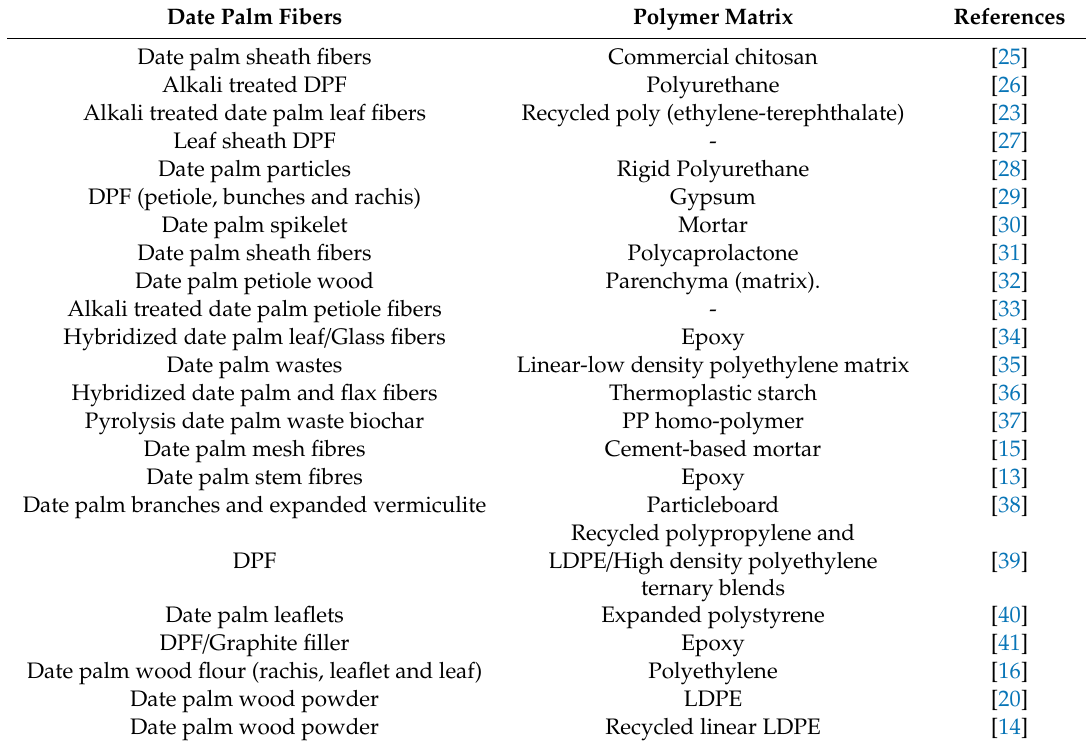
Table 1. Reported studies on date palm material reinforced polymer